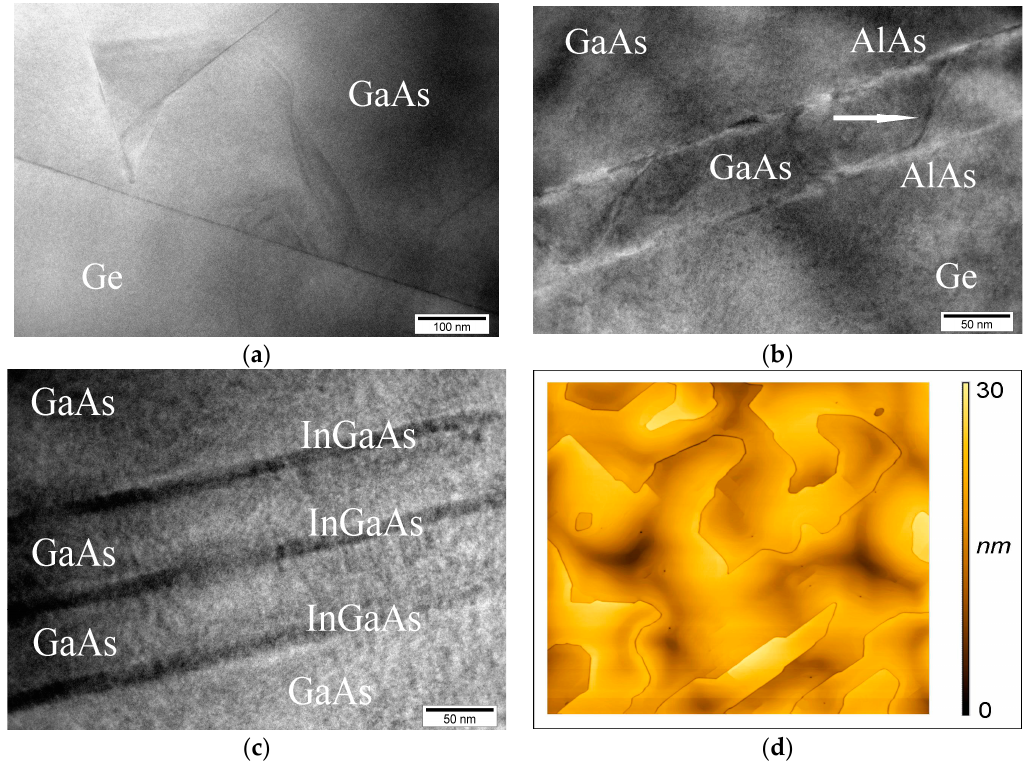
Figure 1. TEM images of the cross section of InGaAs/GaAs/AlGaAs laser heterostructures grown on the Ge/Si substrate: ( a ) GaAs/Ge heterointerface for the sample A, ( b ) the same heterointerface with the AlAs/GaAs/AlAs insertions for the sample B, ( c ) active region with three InGaAs/GaAs QWs of the sample B, ( d ) AFM image of the GaAs layer grown on this Ge/Si virtual substrate with the AlAs/GaAs/AlAs insertions between the main GaAs buffer layer and Ge. Scan sizes are 13 × 13 μ m 2 .